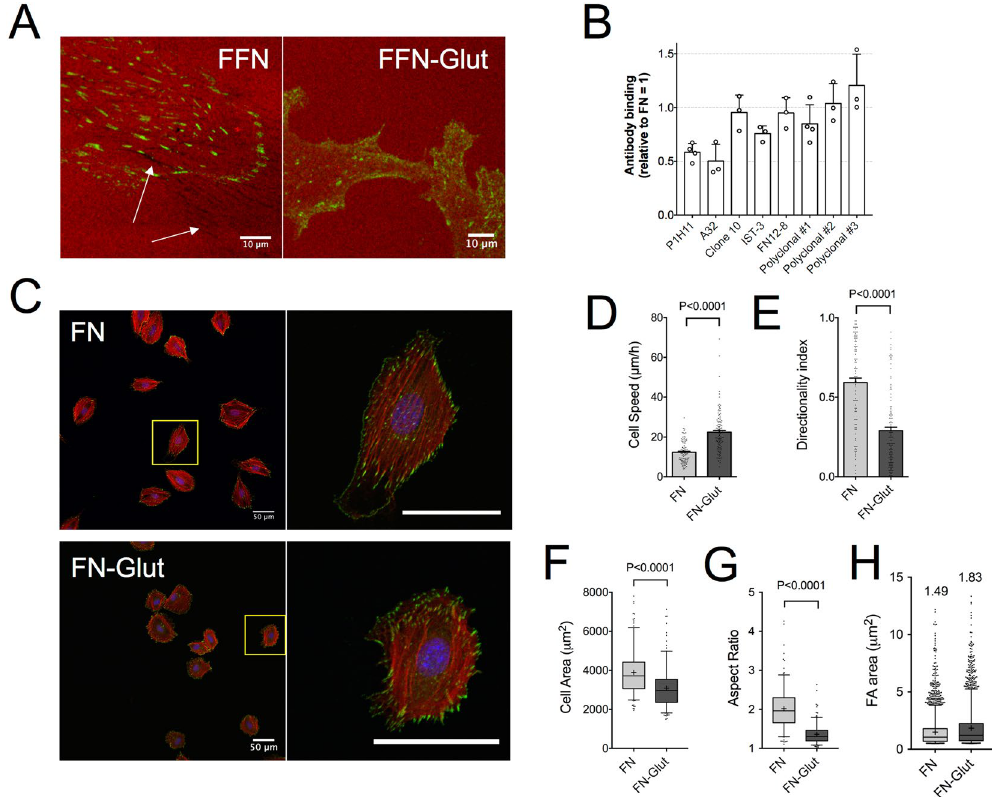
Figure 5. FN cross-linking with glutaraldehyde hinders fibroblast polarization and reduces directional persistence in fibroblast migration. ( A ) Confocal microscopy images of REF, fixed 24 hours after seeding on control substrates coated with 10 μ g/ml fluorescently-labeled FN (red; FFN) or treated with 1% glutaraldehyde (FFN-Glut). Cells were immunostained against tensin-1 (green). Arrows indicate streak-like patterns where FFN was removed (remodeled) from the substrate in the absence of glutaraldehyde cross-linking. ( B ) Quantification of antibody binding to FN-Glut using a modified ELISA assay showed reduced binding compared to FN-coated substrates of some monoclonal anti-FN antibodies (clones P1H11, A32 and IST-3), indicating altered FN conformation upon glutaraldehyde cross-linking. On the other hand, all tested polyclonal antibodies and some of the monoclonal antibodies (clones 10 and FN12-8) displayed similar binding efficiency to FN. Each point represents an independent experiment with n = 2–5. Mean ± s.d. are presented. ( C ) Confocal microscopy images of REF on FN-Glut or FN-coated substrates, fixed 6 hours after seeding and stained against F-actin (red), pY to indicate cell-substrate adhesions (green) and DNA to image the nucleus (blue). Images on the right are zoomed views of the highlighted yellow boxes. Scale bars 50 μ m. ( D ) REF speed increased on FN- Glut, while ( E ) directionality index was markedly reduced compared to FN-coated substrates (N exp = 3; n = 60). Mean ± s.e.m. are presented in ( D , E ). ( F ) REF projected area and ( G ) aspect ratio were lower on FN-Glut substrates ( > 200 cells analyzed; N exp = 2). ( H ) FA area increased on FN-Glut compared to FN-coated substrates (mean values indicated on graph; > 2500 FAs analyzed; N exp = 2). The middle line in box plots indicates the median, the box indicates the interquartile range, the whiskers the 5 th and 95 th percentiles and the cross the mean. Values were compared using an unpaired t-test with Welch’s